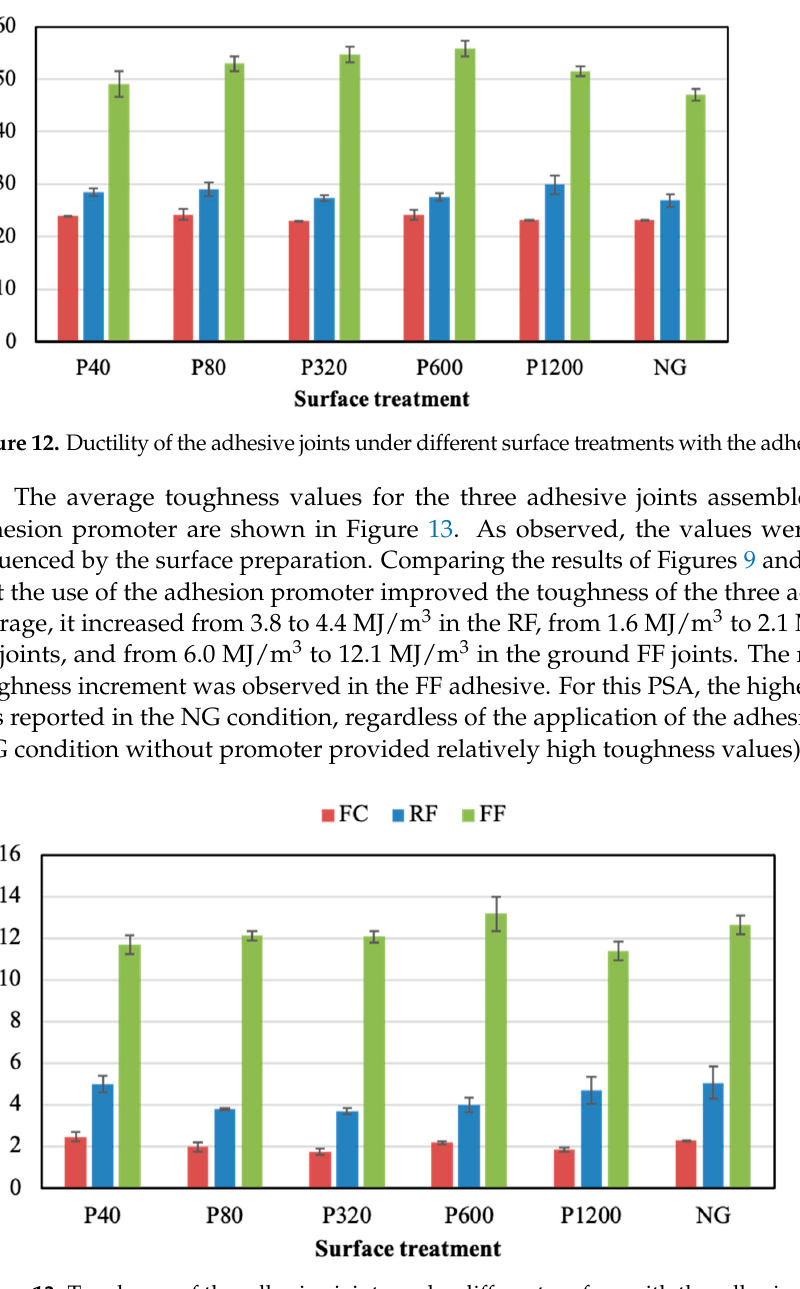
Figure 11. Cohesive failure percentage of the adhesive joints under different surface treatments with the adhesion promoter.